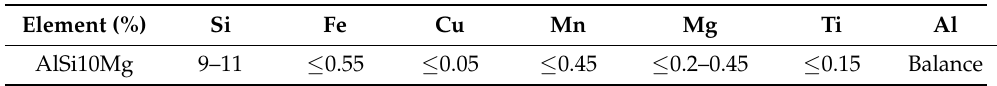
Table 1. AlSi10Mg nominal chemical